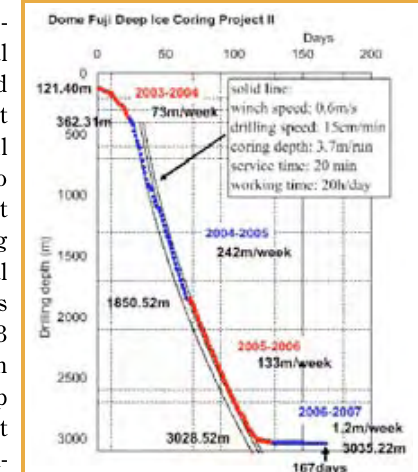
Figure 3. Schematic of a new JARE deep ice coring drill. [A] Chip chamber with many small holes for stable cutting; [B] Adverse current prevention system of chips when the drill is raised; [C] Development of special alloy for cutter which can be used to core cold hard ice as well as “warm” softer ice.